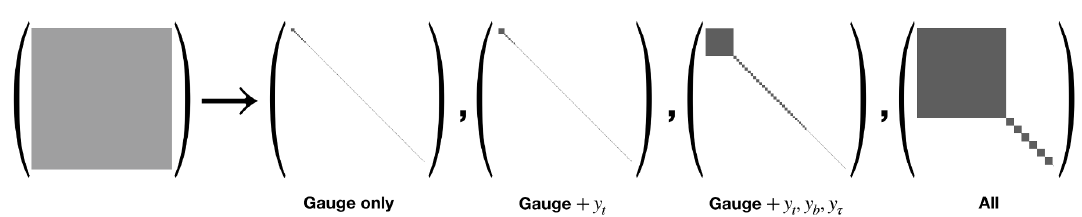
Figure 4 . Scale representation of the block diagonalisation of the anomalous dimension matrix of the (4 , 0) operators that occurs under various approximations of the SM interactions, as listed in table 9. (Here, the “Gauge + y ” scenario is assuming the full (non-unit) CKM, i.e. it t , y b , y τ corresponds to the penultimate row in table